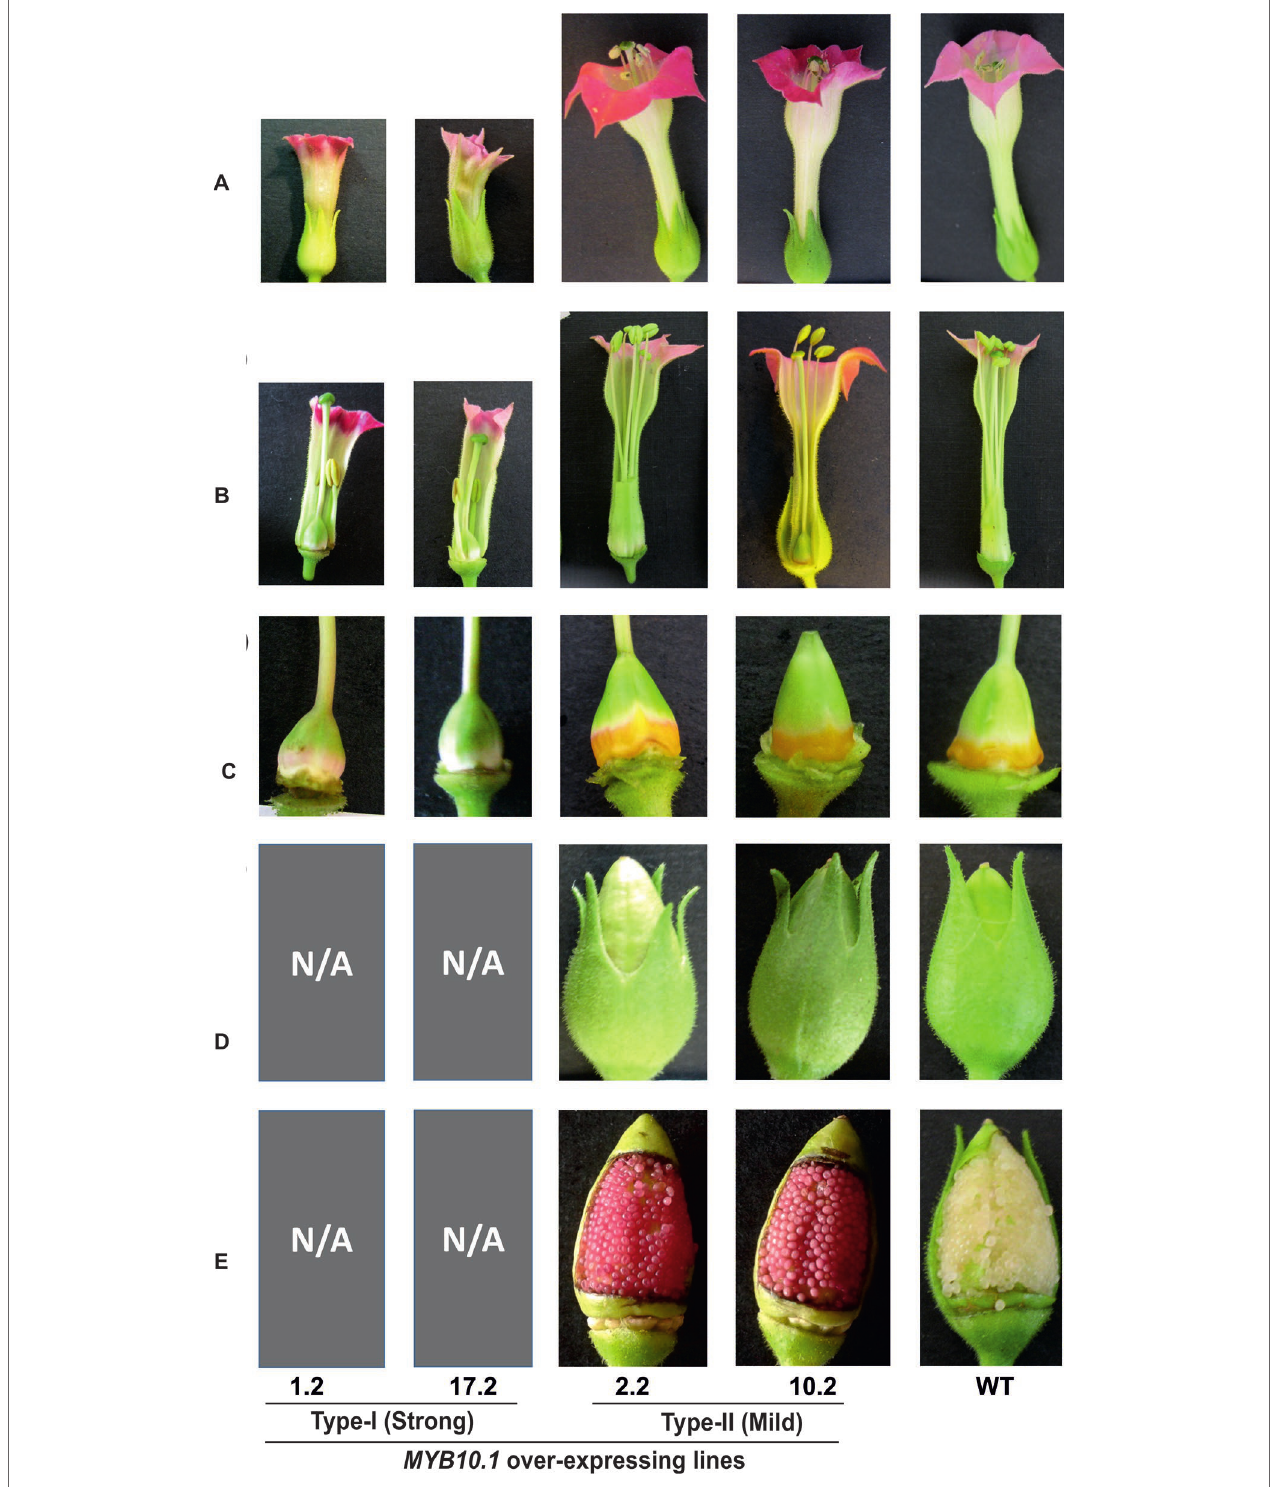
FIGURE 4 | Floral phenotypes of MYB10.1 overexpressing transgenic tobacco lines compared to WT. (A) Complete flowers; (B) open flowers showing the anther- stigma distance; (C) nectary region of the ovary, missing in strong lines; (D) green capsules; and (E) open capsules showing seed coat pigmentation, reddish in mild phenotypes. N/A indicates the absence of capsules and ovules/seeds in type I transgenic